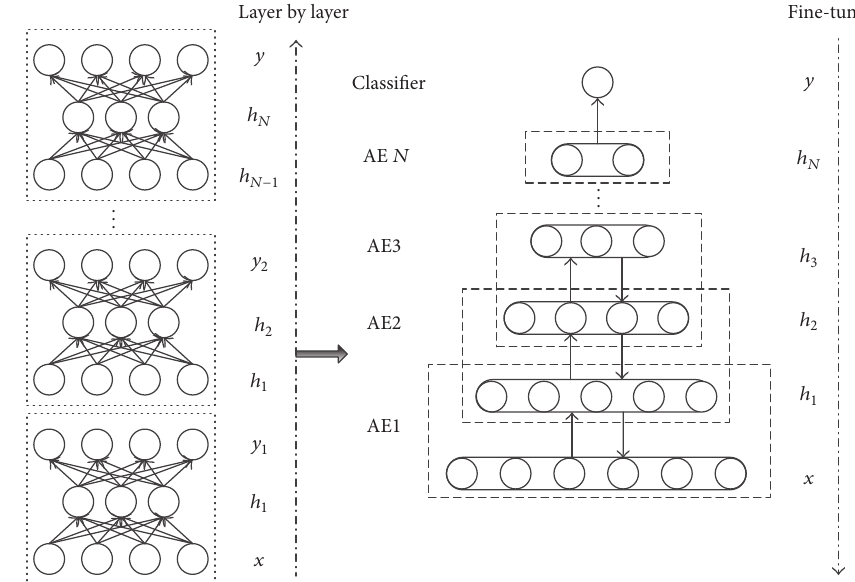
Figure 2: The structure of